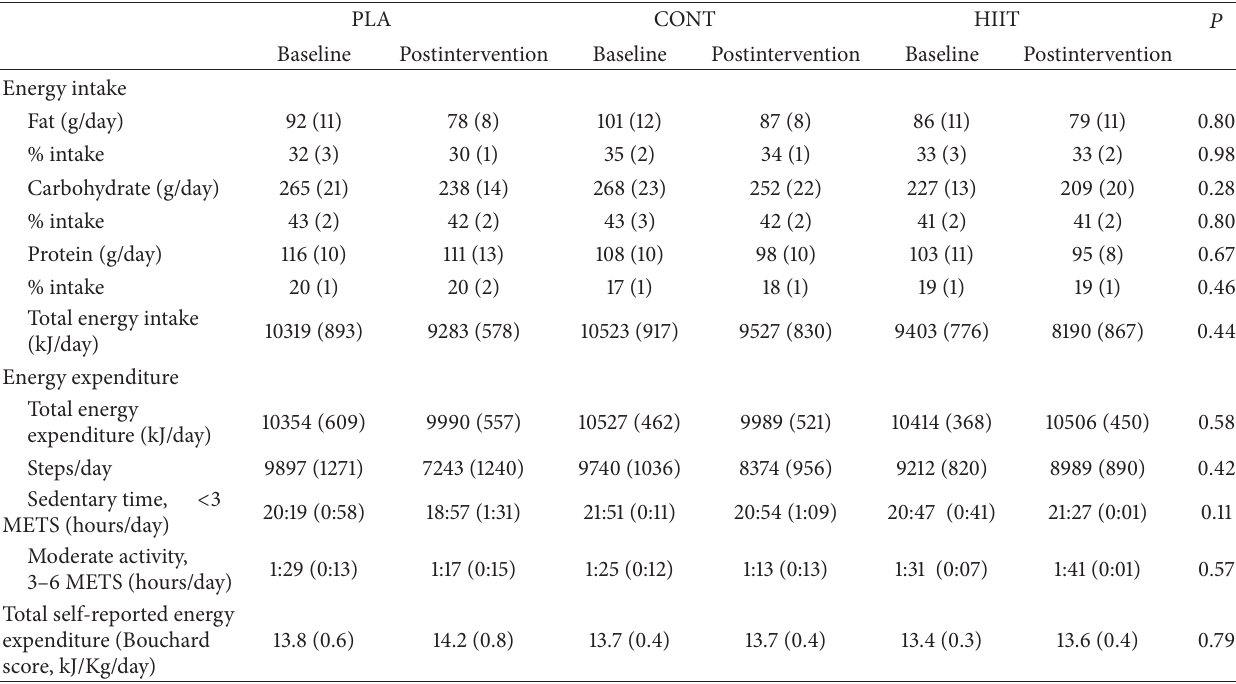
Table 4: Habitual energy intake and energy